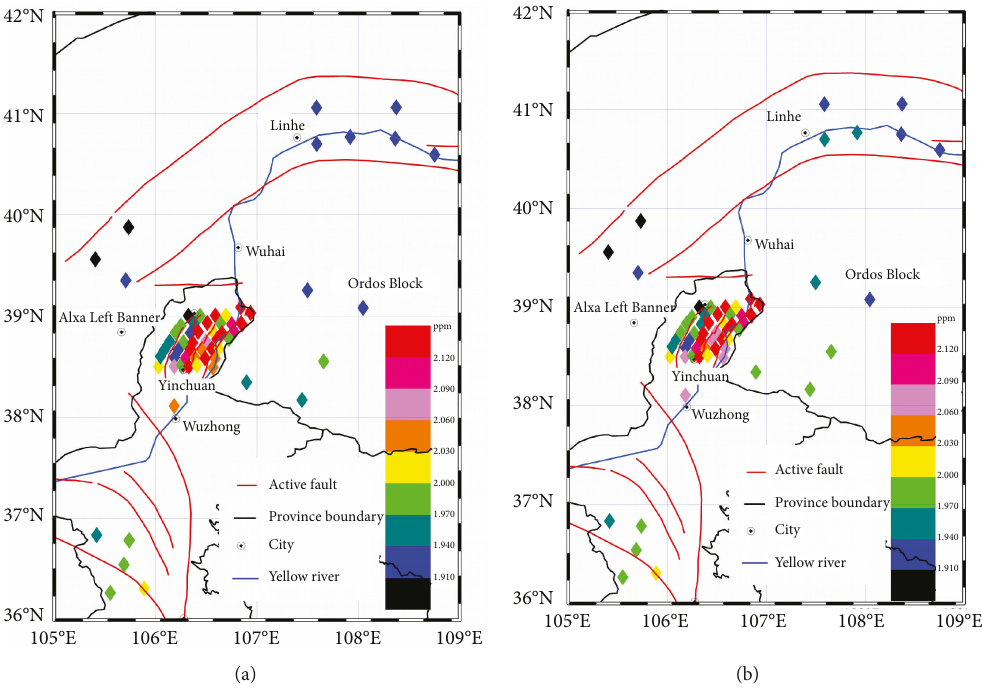
Figure 2: Distributions of CH concentrations at (a) a height of 1.5m and (b) the surface (0 m), for di ff erent tectonic settings along the 4 western margin of the Ordos